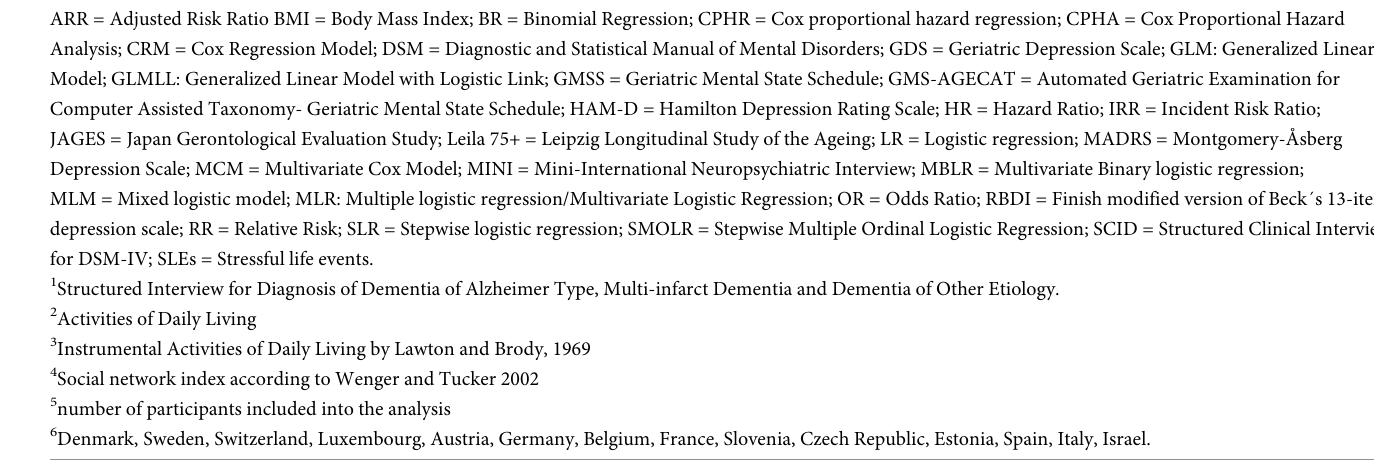
depression scale with cut-off set at four (less rated as no symptoms), and the EURO-D scale with cut-off set at four. Three studies applied the GMS-AGECAT system, all using the recom- mended GMS-AGECAT level three or higher [46] for definition of incident depression. In two surveys on a French three city study, the Mini Neuropsychiatric Interview (MINI) and CES-D-20 with a cut-off at 16 were used. One study used the Structured Clinical interview